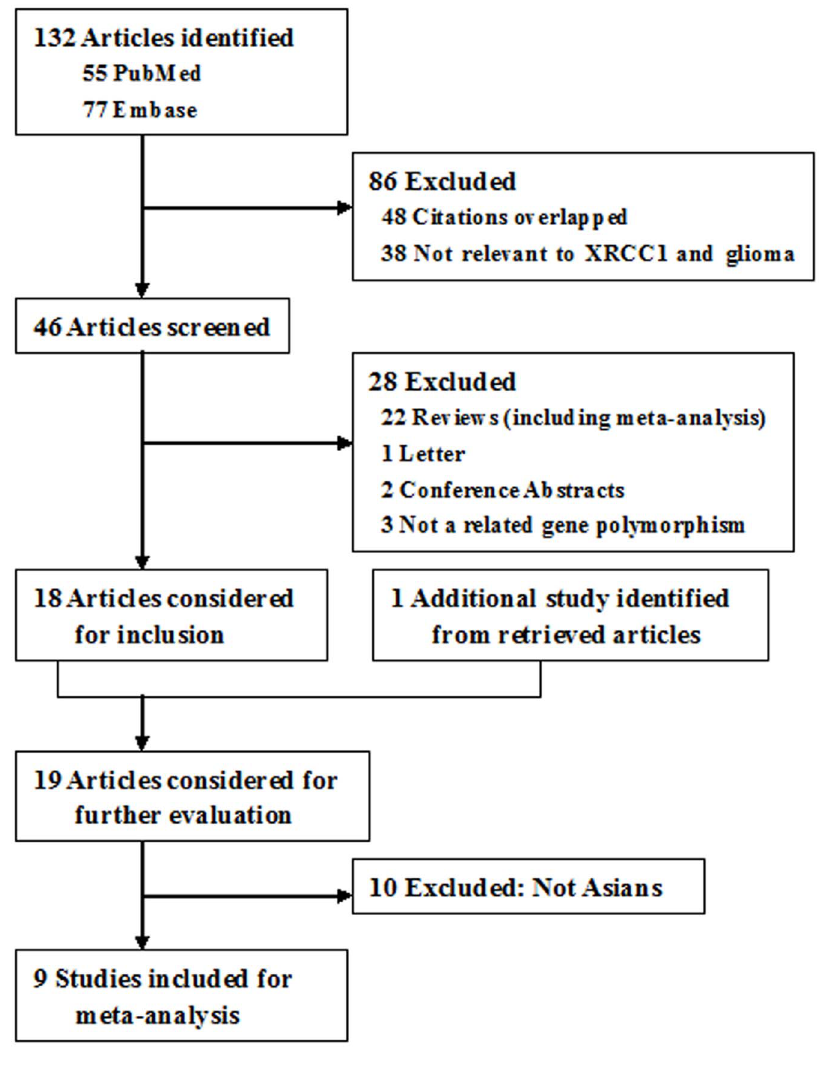
Figure 1. Flow of Included Studies.